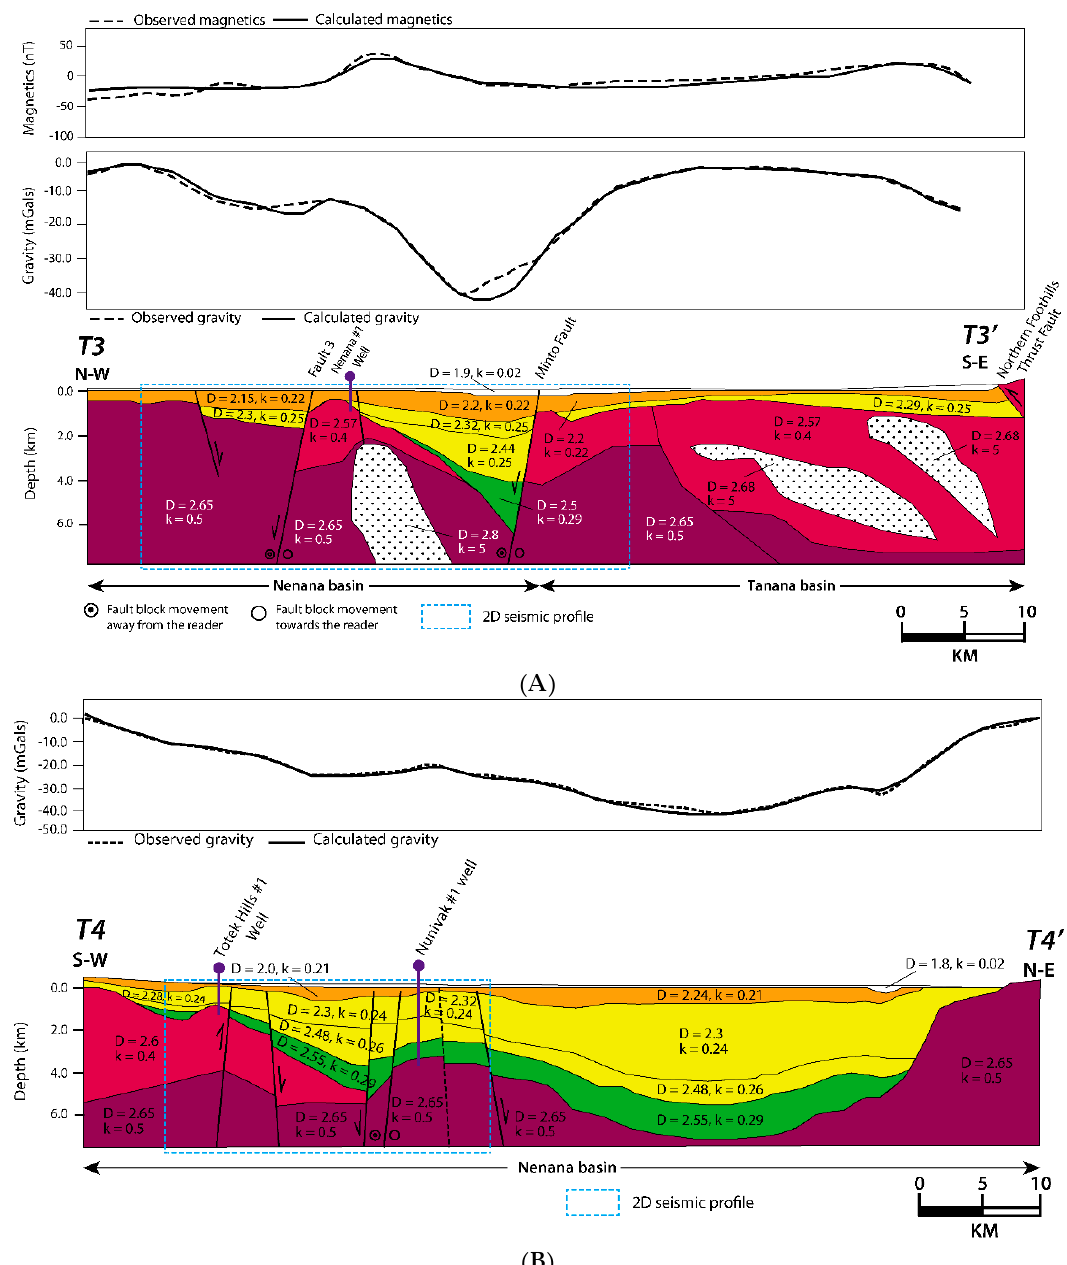
Figure 12. A total of 2 ½ gravity and magnetic models across the Nenana basin. ( A ) Model T2 is oriented NW–SE across the southern part of the Nenana basin. ( B ) Model T4 is oriented NE–SW, parallel to the strike of the Nenana basin. The profile locations are shown in Figure 3. The upper panels show observed (dotted black line) and calculated (solid black line), gravity and magnetic anomaly curves. The lower panel shows the potential field model with individual source bodies colored by lithology and labeled with density ( × 10 3 kg/m 3 ) and magnetic susceptibility ( × 10 3 SI). Blue dotted line shows the limit of seismic reflection data in our study area. Table 1 summarizes measured average magnetic susceptibility and rock density values for modeled lithologic units in our study